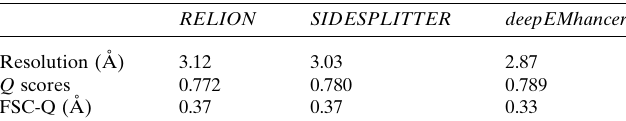
Table 1 Validation metrics for different reconstructions of (cid:2) -galactosidase. FSC resolution first, followed by two map-to-model validation